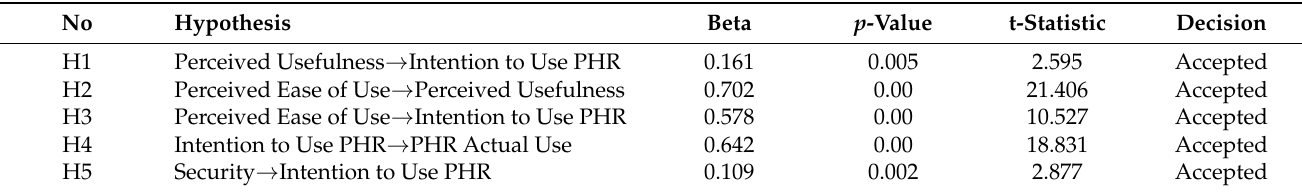
Table 4. Direct Relationship Hypotheses.